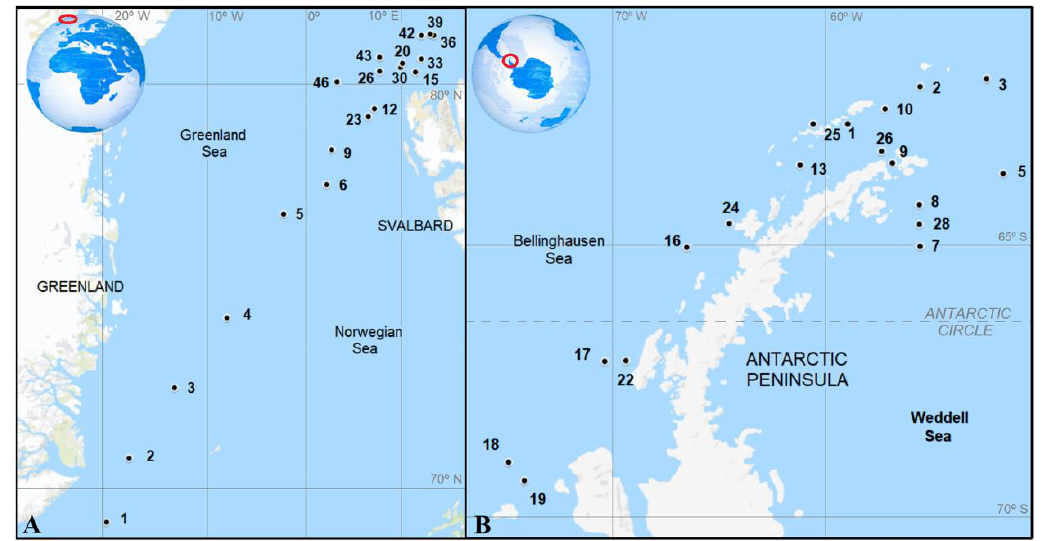
Figure 1. Map of sampled stations in the Arctic (Greenland Sea and around Svalbard) ( A ) and Antarctic waters (Bransfield Strait, Weddell Sea, and Bellingshausen Sea) ( B ) during ATOS1 and ATOS2 cruises, respectively.